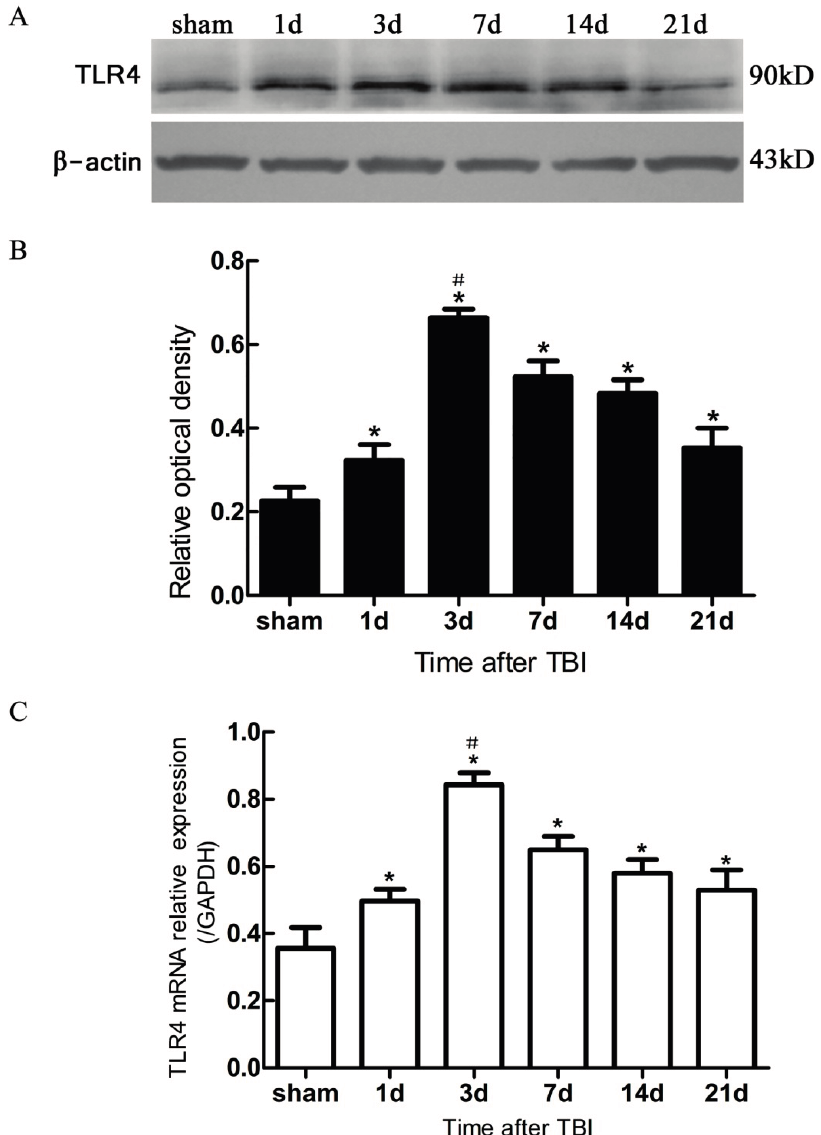
Figure 4. Expression of hippocampal TLR4 protein and mRNA in sham- and TBI-mice, by Western blotting and real-time polymerase chain reaction (PCR). ( A ) Western blotting: electrophoresis bands of TLR4 protein with β -actin as loading control; ( B ) Western blotting: optical density value of TLR4 protein electrophoresis; ( C ) real-time PCR: TLR4 mRNA relative expression, GAPDH was used as endogenous reference gene. TBI-mice had a significantly higher expression of TLR4 in either protein or mRNA than the sham ( * p < 0.05), and showed an obvious difference in the level of TLR4 expression between